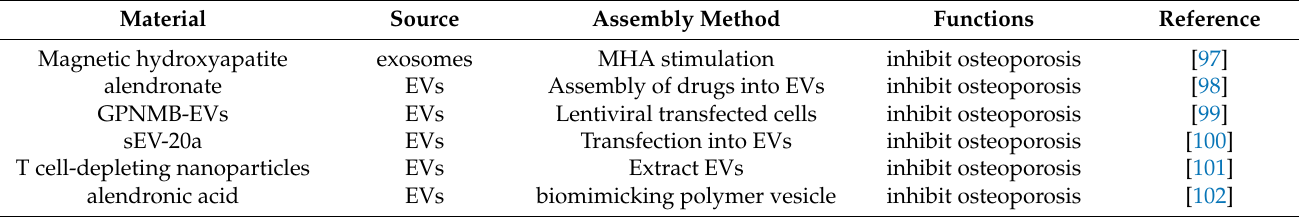
Table 5. The role of engineered EVs in